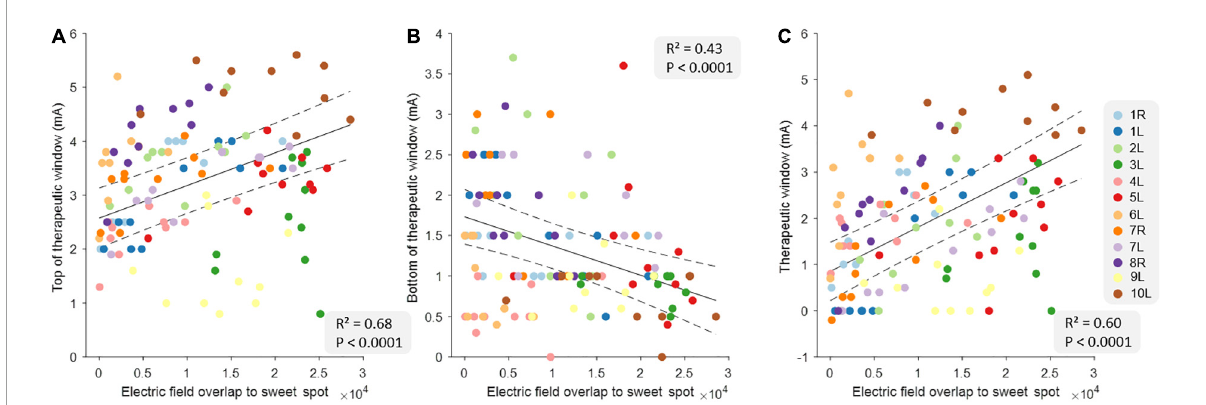
FIGURE2 Relationship between clinical measures and electric field overlap to the sweet spot at the group level. The relationship between top of therapeutic window (tTW) (A) , bottom of therapeutic window (bTW) (B) , and therapeutic window (TW) (C) and the electric field overlap to the sweet spot at the group level ( n = 120). The colors indicate the 10 deep brain stimulation (DBS)-contacts (i.e., eight individual contacts and two segmented contact levels in ring mode) of the different hemispheres as is shown on the legend on the right side. The black lines indicate the slope of the linear mixed models with CI (dashed lines).